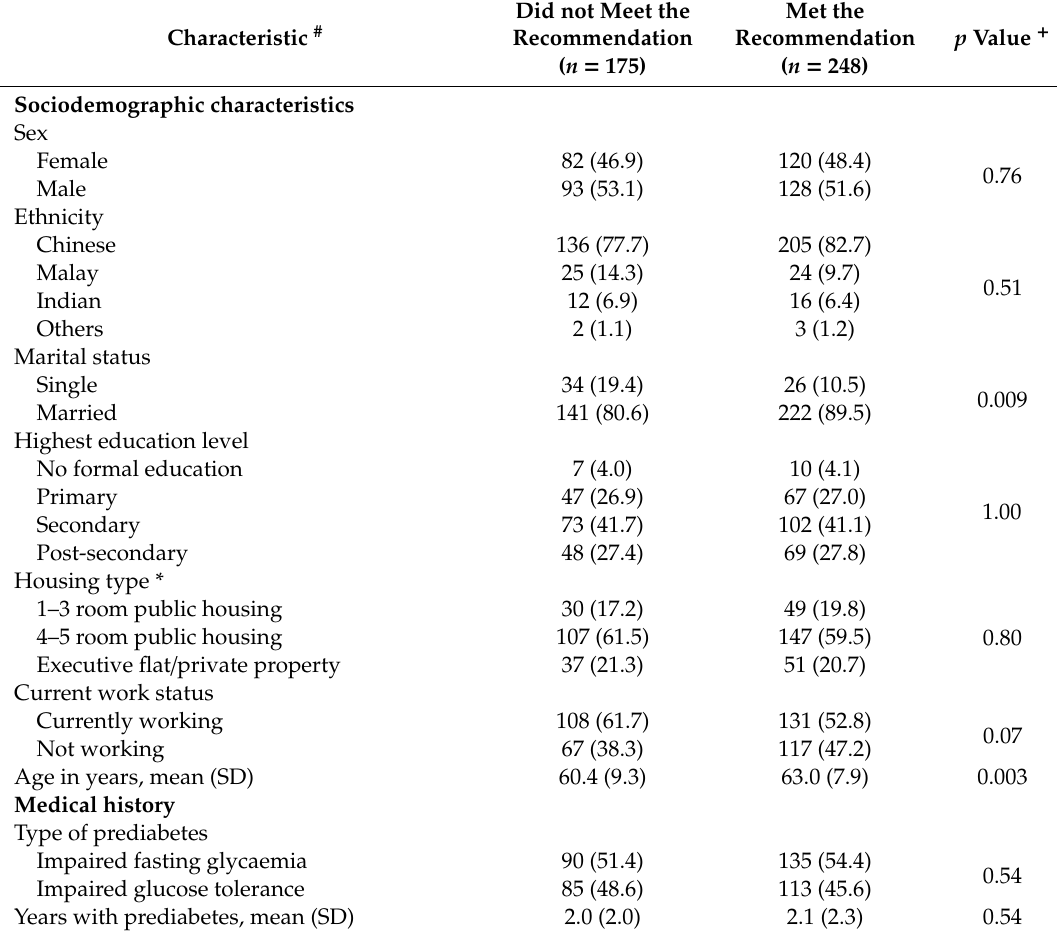
Table 1. Comparison of sociodemographic characteristics, medical history and dietary habits for those reported meeting and not meeting My Healthy Plate recommendation (excluding those on special diet). Did not Meet the Recommendation Characteristic # ( n = 175)